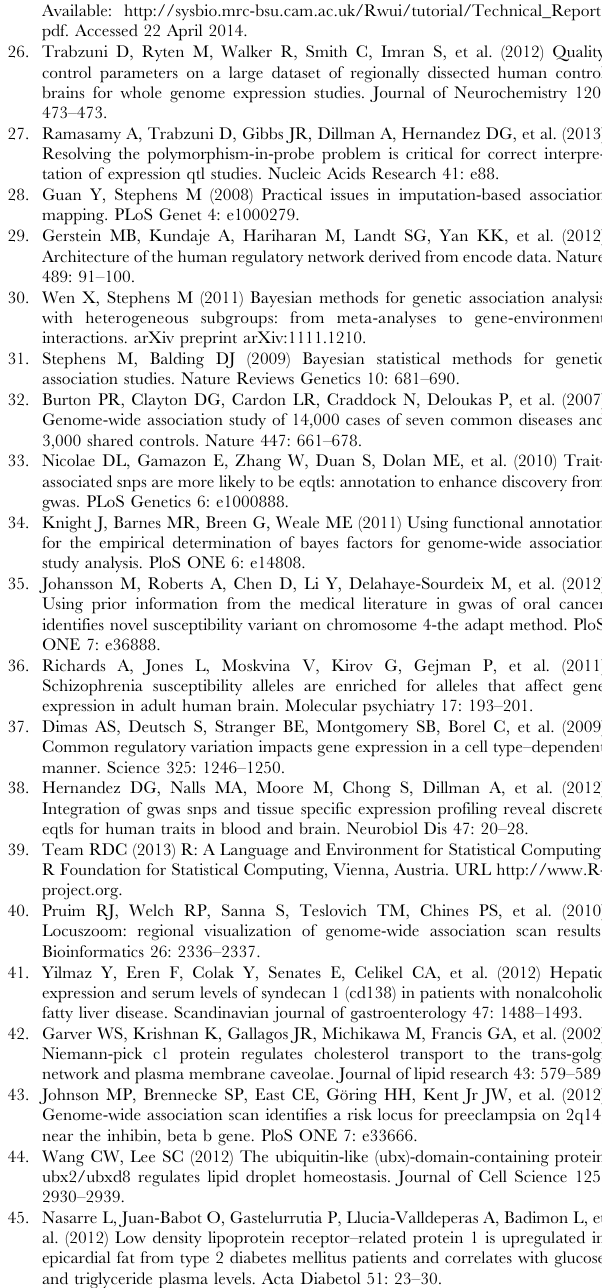
Text S1 Supplementary materials. Expanded methods, deriva- tions and analyses. Text S2 Overview of gene function of new colocalisation results associated with blood lipid levels and liver